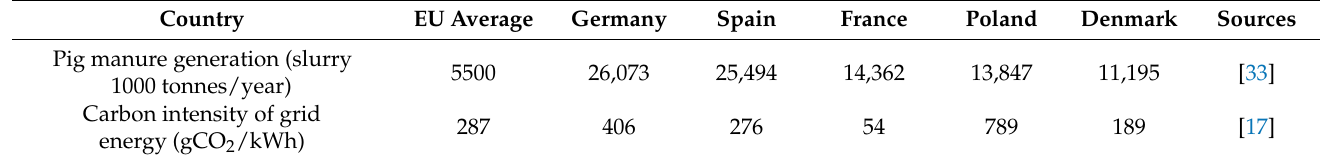
Table 9. PM opportunities in different EU